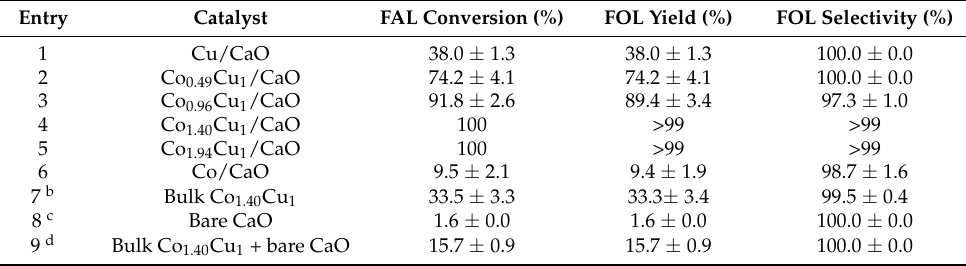
Table 1. Catalytic activity for FAL hydrogenation to the target FOL product over the different catalysts a